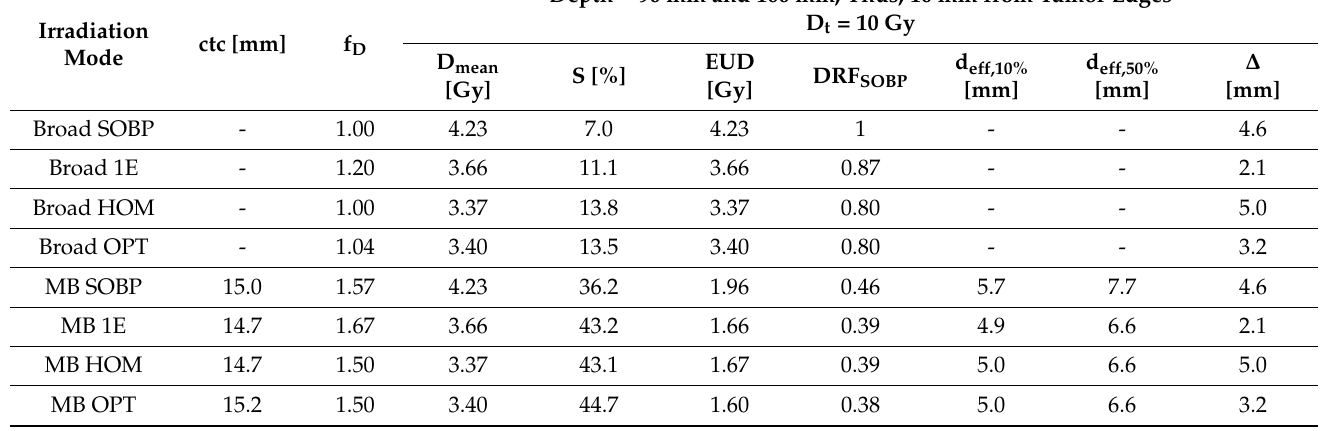
Table 2. Characteristics of the different irradiation